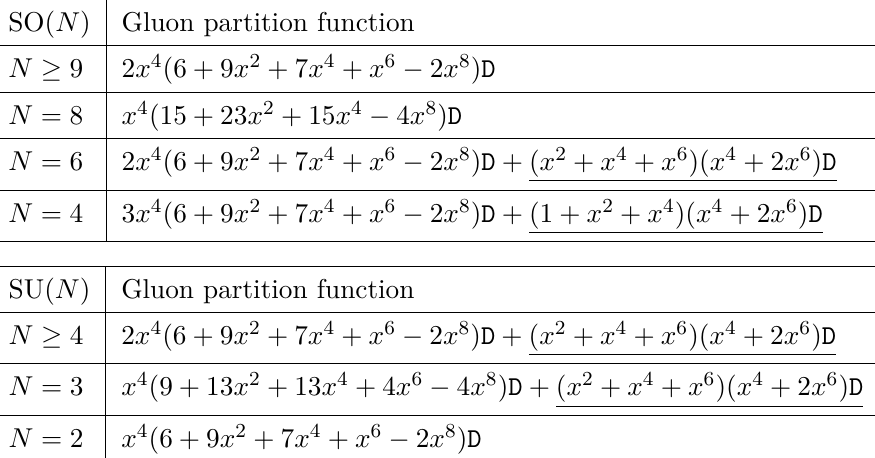
Table 8 . Partition function over the space of Lagrangians in D = 4 involving four F a D ≡ 1 / ((1 − x 4 )(1 − x 6 )) . Contribution of M non-inv is underlined. The rest is the contribution of M inv . Partition function for SO(5) and SO(7) is the same as that for SO( N ) for N ≥ 9 .